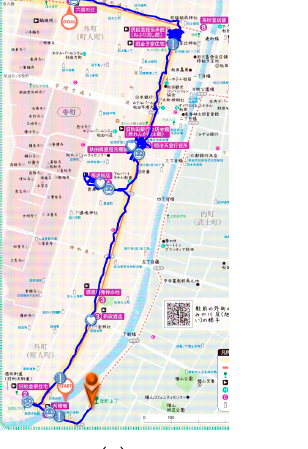
(cid:17) (cid:16) Error staying